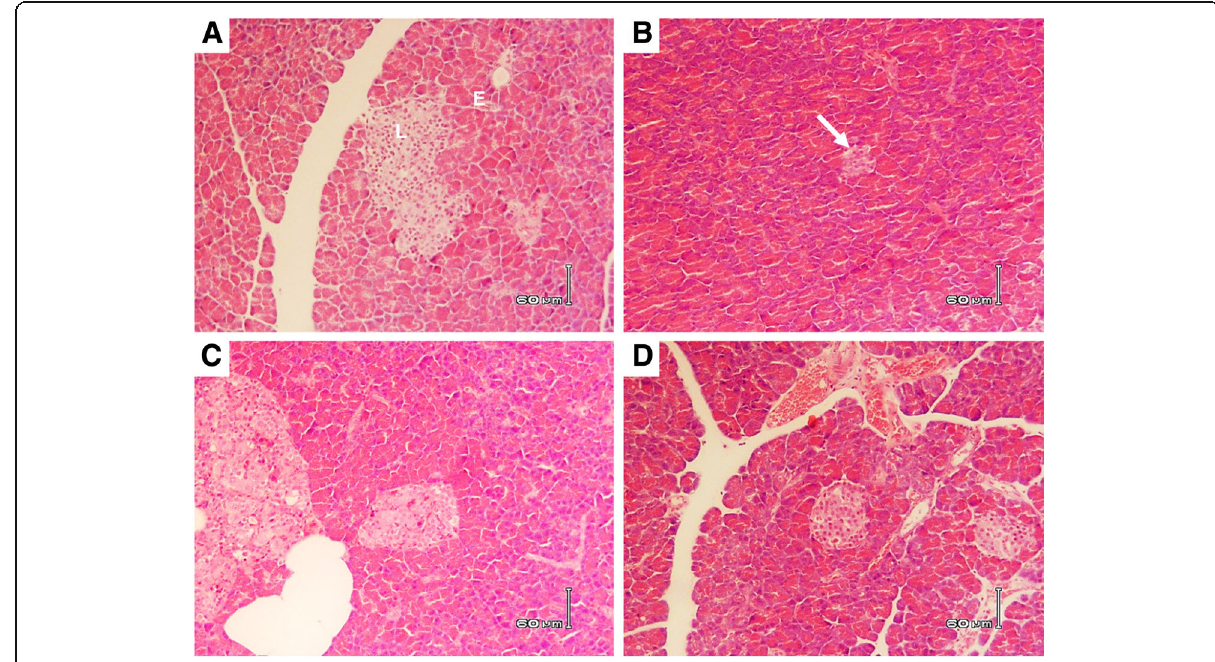
Fig. 3 The effect of RA-3 on pancreatic islet morphology of STZ-induced type 1 diabetic rats. a Normal control group, ( b ) Untreated diabetic group, ( c ) RA-3 treated group, and ( d ) Metformin treated group. (L) indicates a normal islet without any histological alterations, (E) exocrine portion of pancreatic tissue and an arrow illustrates STZ-induced shrinkage of islets .NB: For each image the magnification (200X). Bar indicator is 60 μ